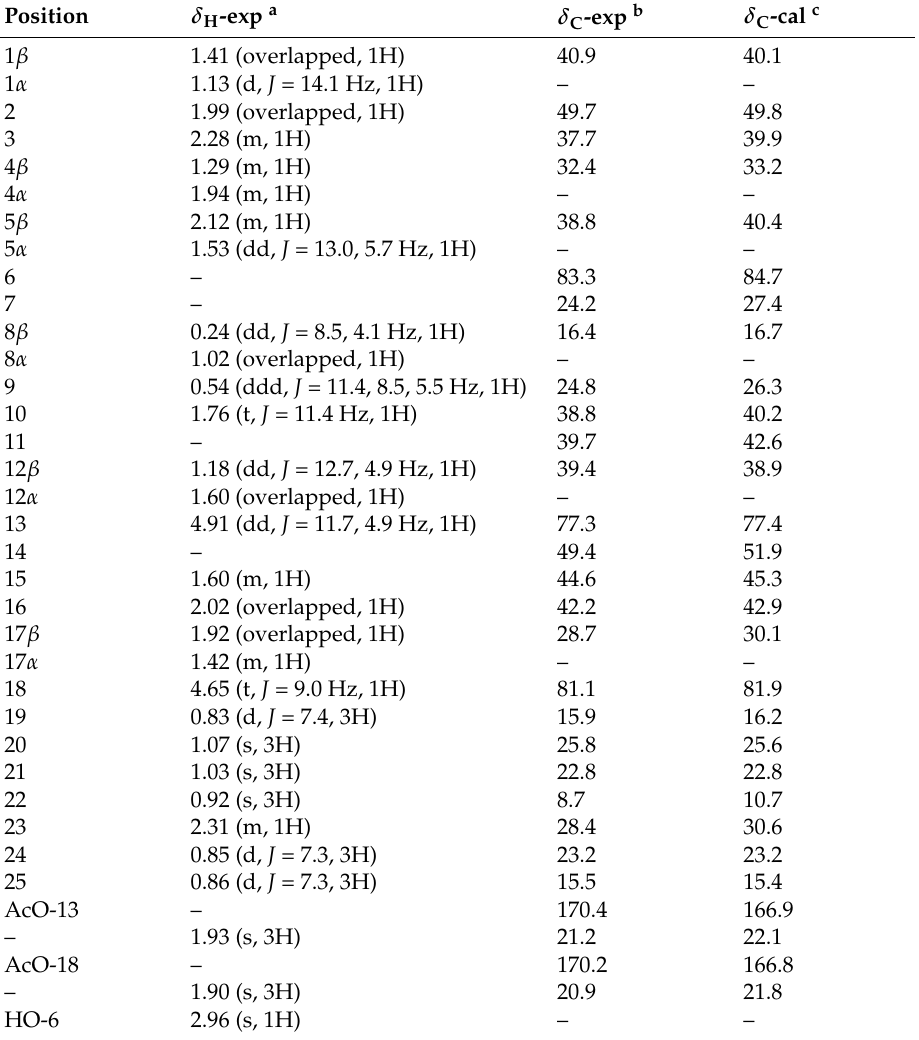
Table 1. Experimental and calculated spectroscopic data of gypmacrophin A ( δ in ppm, recorded in acetone- d 6